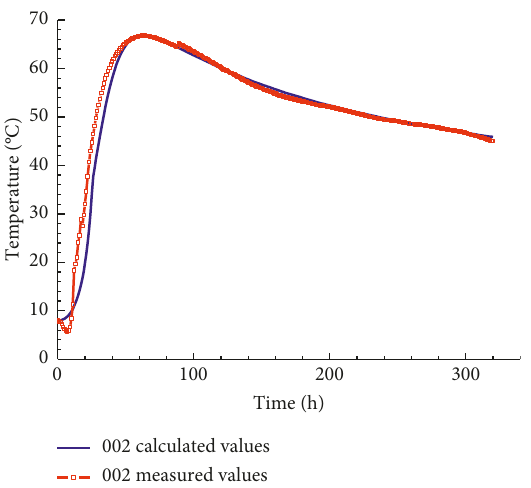
Figure 13: Comparison between the calculated and measured values for Point 002.